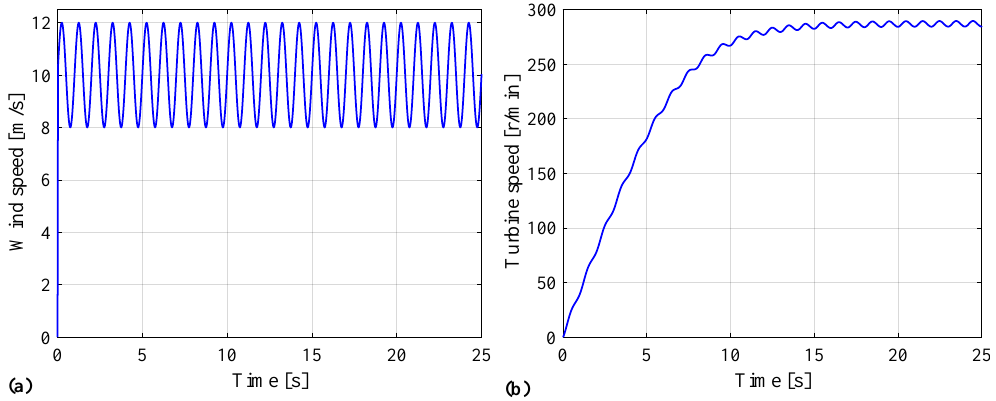
Figure 16. ( a ) Wind speed input of 1 Hz and ( b ) turbine (generator) speed response versus